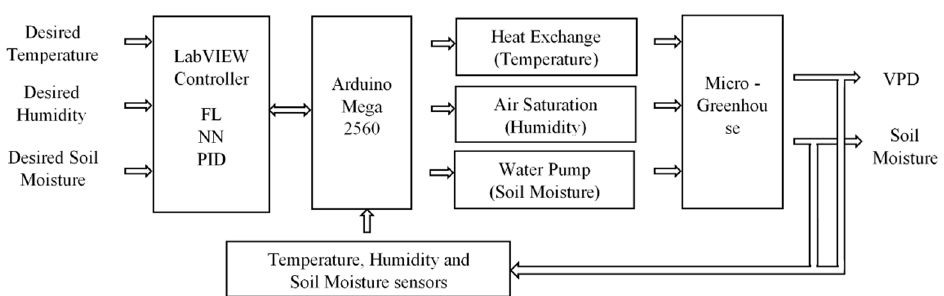
Figure 4. Control system general diagram.